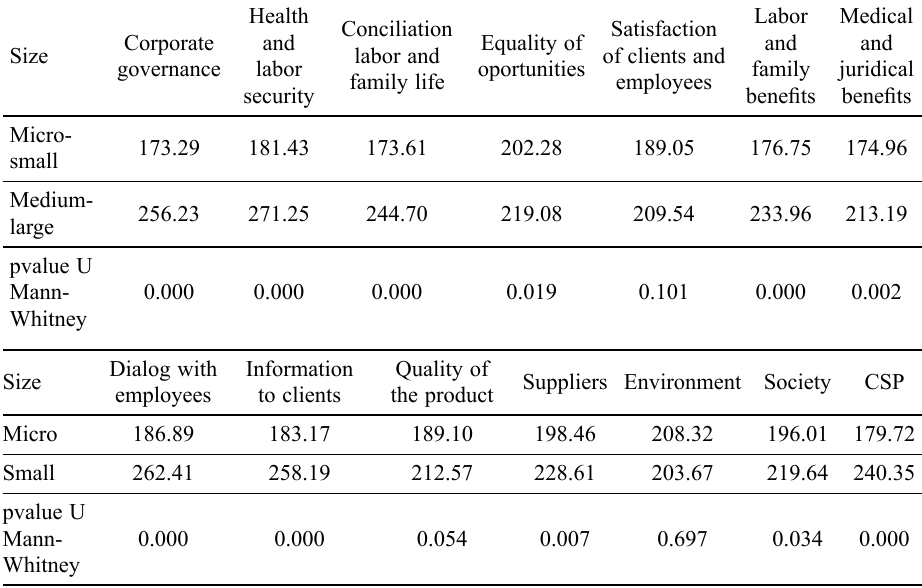
Table 4. Comparative analysis of the factor scores of the micro-small